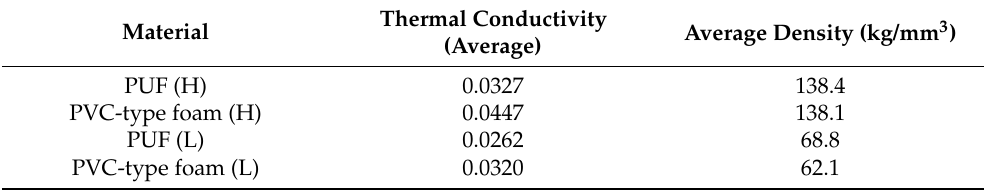
Table 4. Thermal conductivity of PVC-type foam and neat